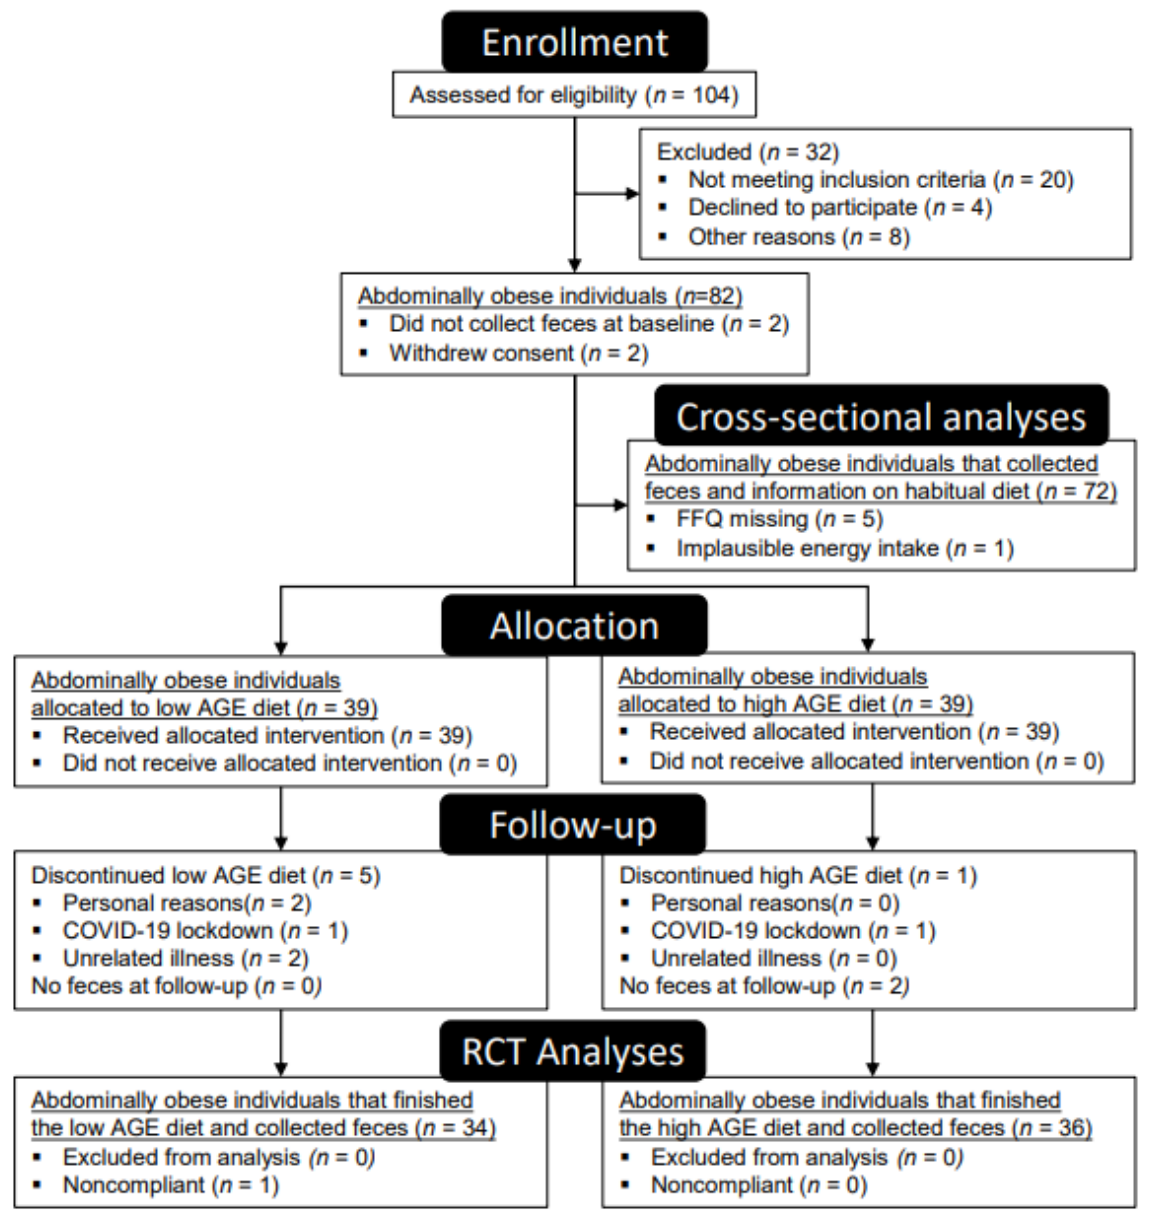
Figure 1 . CONSORT flow diagram for RCT and cross-sectional analyses. Figure 1. CONSORT flow diagram for RCT and cross-sectional